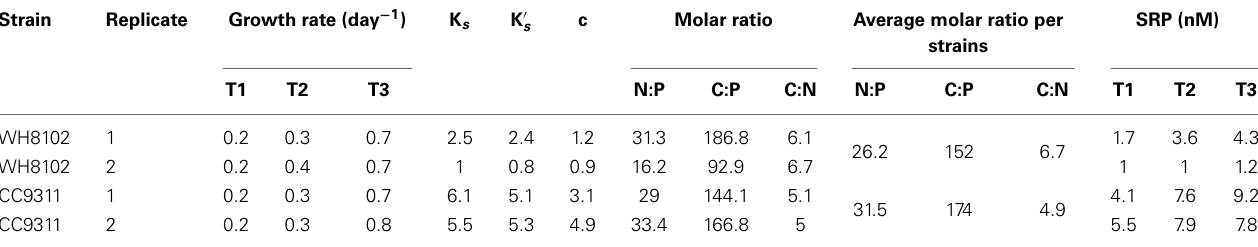
Table 1 | Summary of measured and calculated parameters, including averaged growth rate (at the 3 time intervals, T1, T2, and T3), K s and K (cid:2) s (ranges for the K s , p value), c , the drawdown value for phosphate, averaged soluble reactive phosphorus (SRP) per time interval, and molar averaged C:N:P ratios and the average molar ratios per strains using the raw measurements.